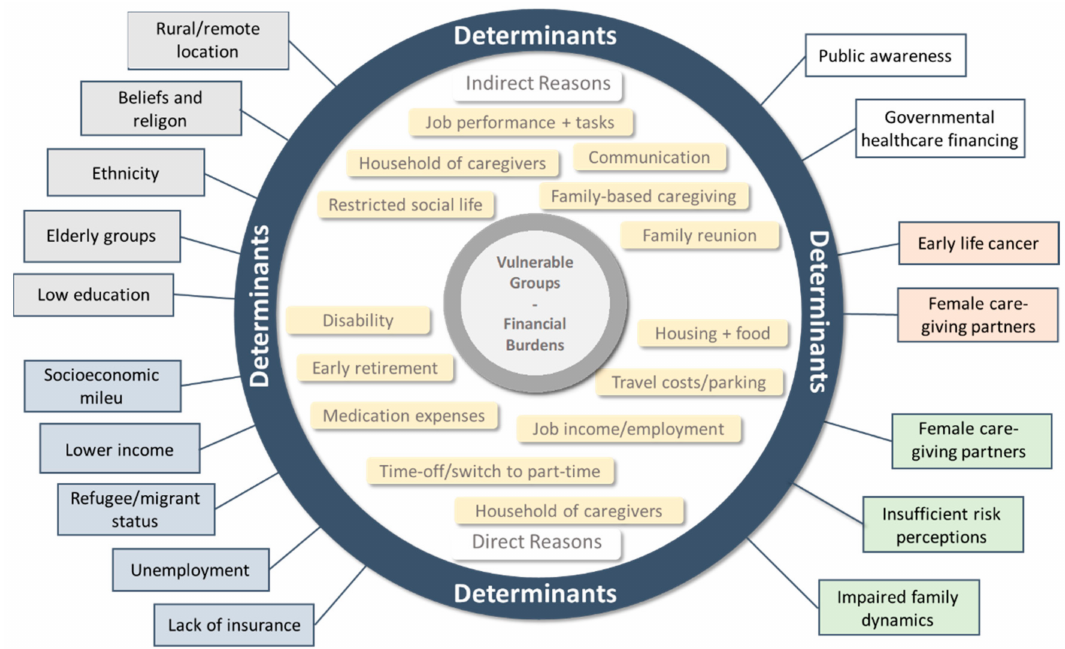
Figure 2. Direct and indirect reasons and determinants (grey: demographic; blue: economic; white: public; red: disease-related; green: social) of financial burden in vulnerable groups for cancer